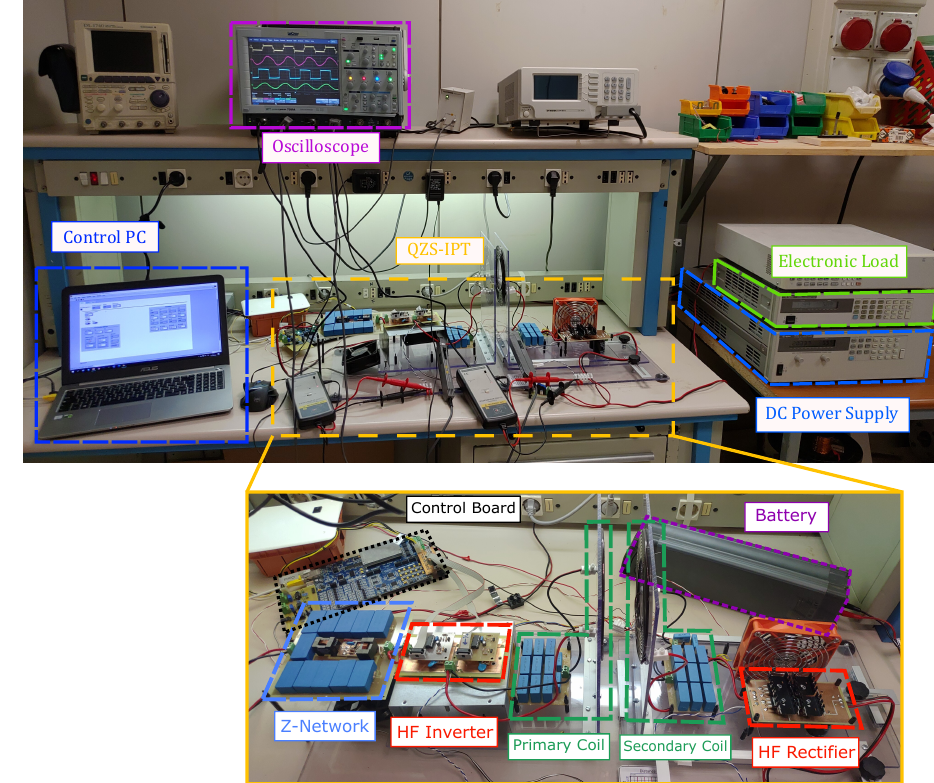
Figure 7. Setup of the laboratory prototype for the proposed qZS-IPT